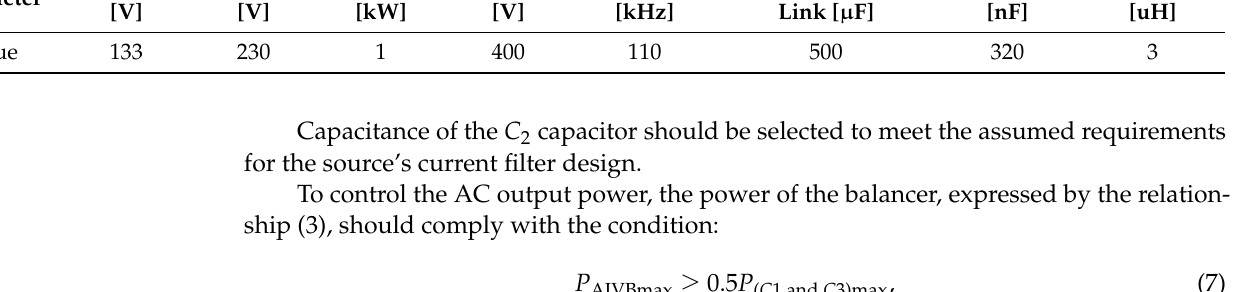
Table 1. Parameters for simulation of the proposed SC-AC system.